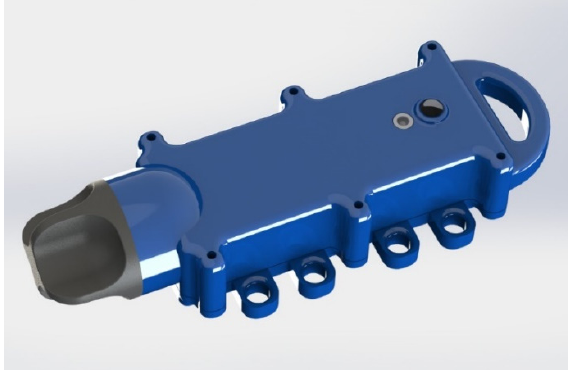
Figure 5. 3D view of the enclosure designed for the device.